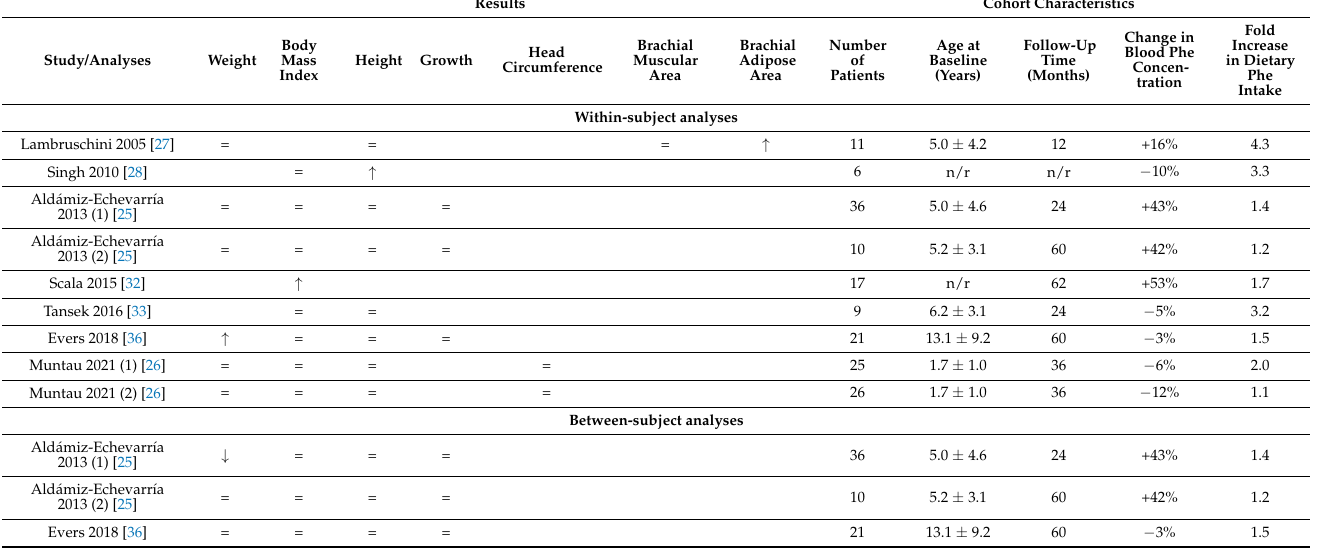
Table 3. Results of within-subject (baseline versus last point of follow-up during BH 4 treatment) and between-subject (BH 4 -treated group versus control group at last point of follow-up) analyses for different parameters regarding anthropometric measurements. Cohort characteristics are taken from Table 2. =, no significant change (within-subject analyses) of no significant difference (between- subject analyses); ↑ , significant increase or significantly higher in BH 4 -treated group (if not already significantly higher at baseline); ↓ , significant decrease or significantly lower in BH 4 -treated group (if not already significantly lower at baseline). N/r, not